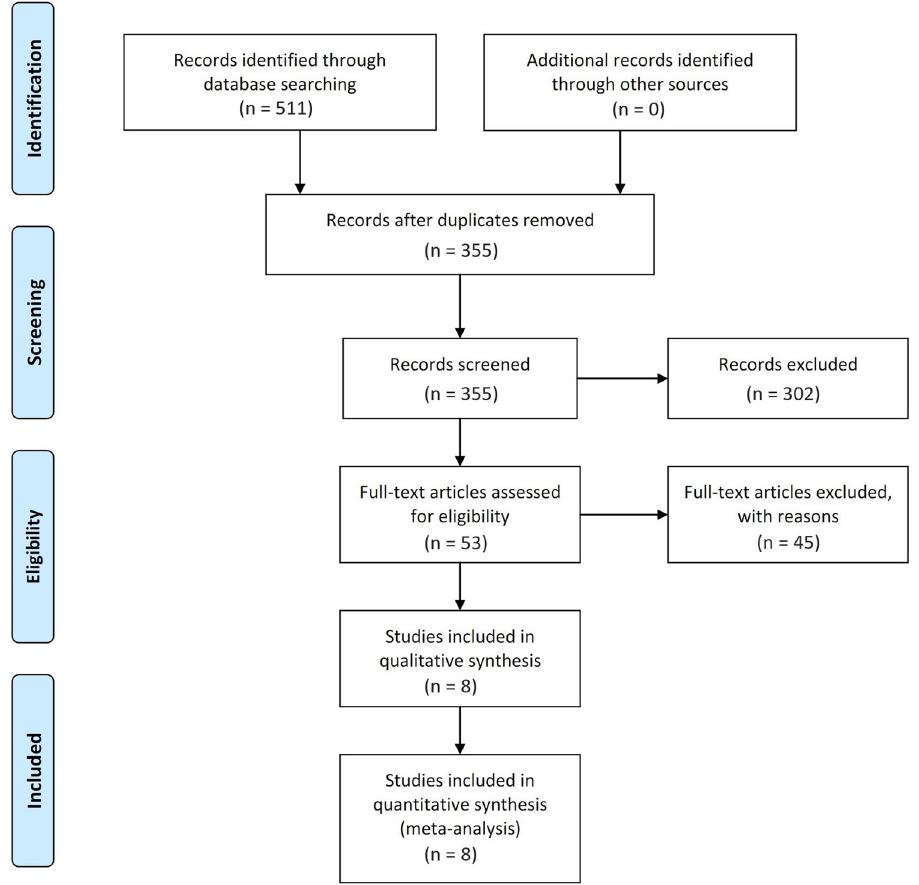
Fig 1. Search strategy for a systematic review and